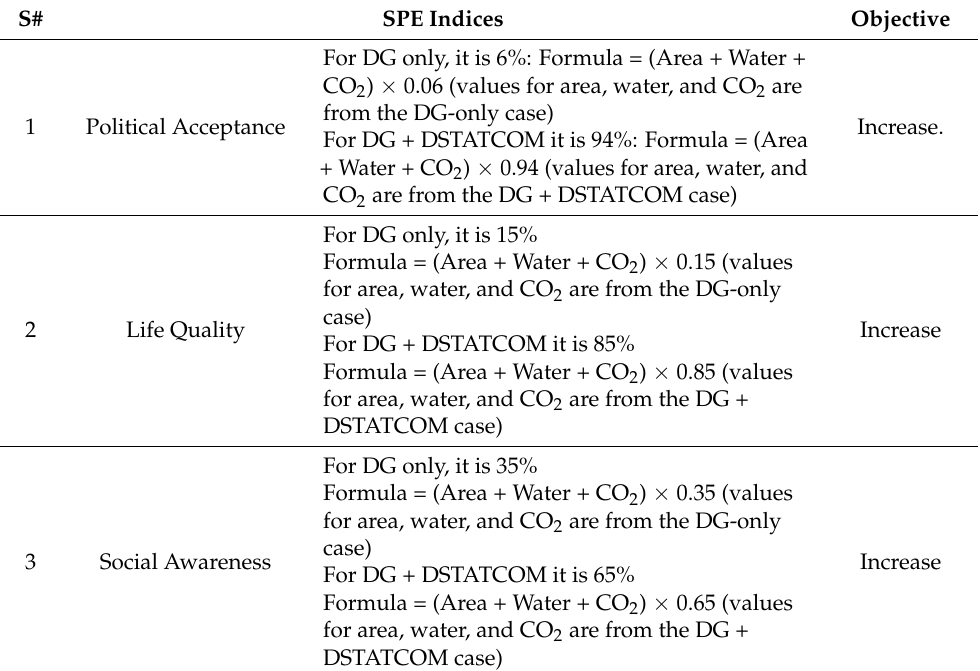
Table 6. Social performance evaluation (SPE) indices